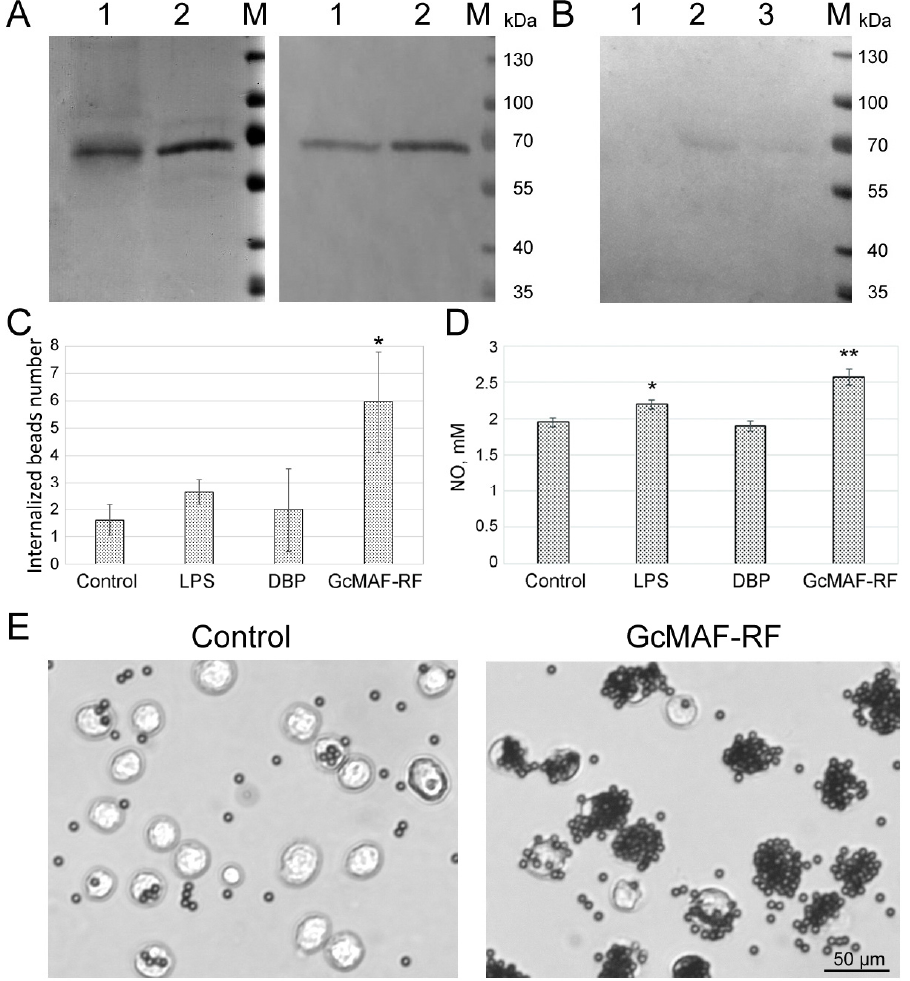
Figure 1. Characterization of DBP and DBP-derived GcMAF-RF. ( A ) Polyacrylamide gel of DBP samples obtained using actin-agarose (1), and Sepharose (with 25-hydroxyvitamin D 3 ) (2) affinity chromatography (left) and Western blot of these samples with antibodies against Gc group proteins (right). ( B ) Western blot of a polyacrylamide gel for Helix pomatia lectin. 1—DBP, 2—GcMAF-RF, and 3—FBS. M—Thermo ScientificTM Page RulerTM Prestained protein Ladder molecular marker (Thermo Fisher Scientific Inc., Waltham, MA, USA). ( C ) Phagocytic activity of murine PMs treated